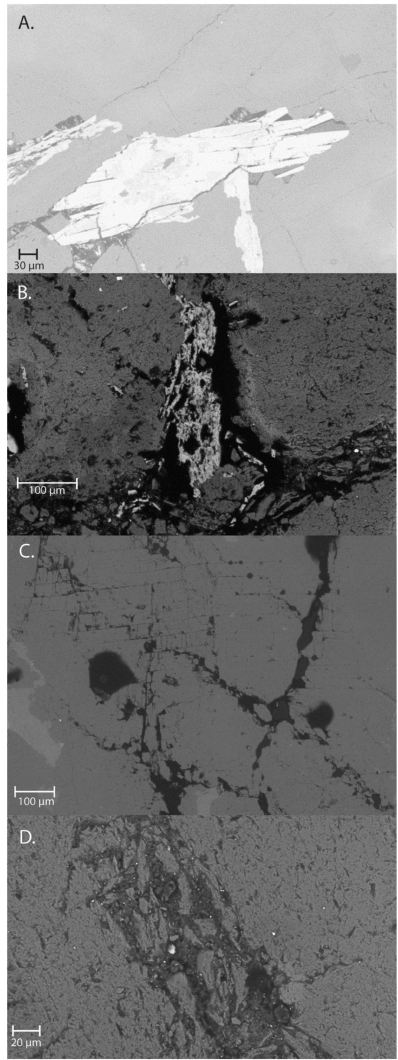
Figure 2. Scanning electron micrographs of biolixiviant reacting with minerals in Picacho tailings. ( A ) Shows a bright mineral (Fe-rich) surrounded by a lighter gray mineral (feldspar). ( B ) Fe-rich grain is disaggregated and invaded by a bioslime. ( C ) Network of cracks invaded by bioslime. ( D ) Bioslime fracture showing bright spots corresponding to heavy